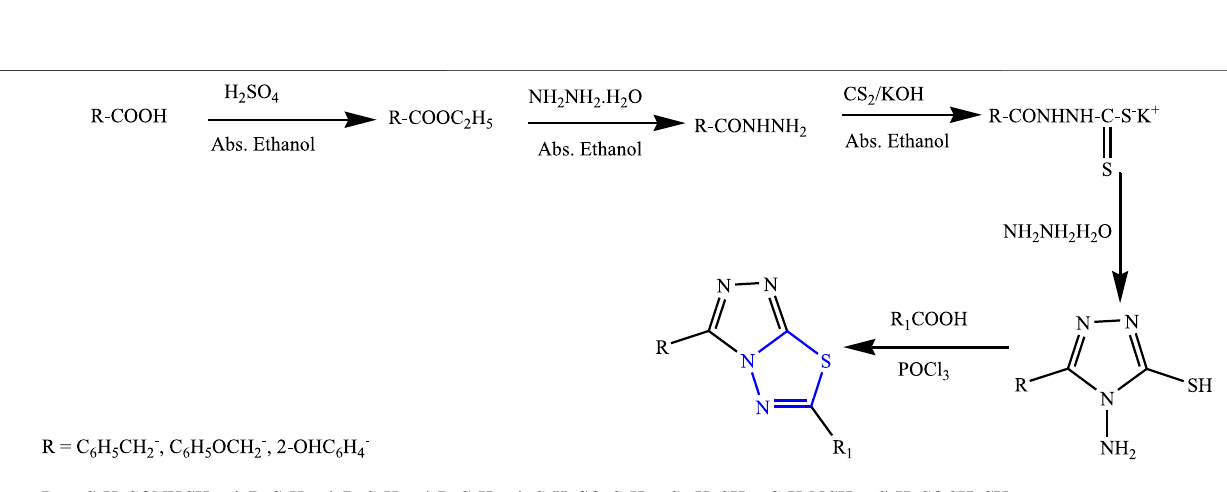
FIGURE 28 | Synthetic pathway for synthesizing new phenyl isothiocyanate 1,3,4-thiadiazole derivatives.